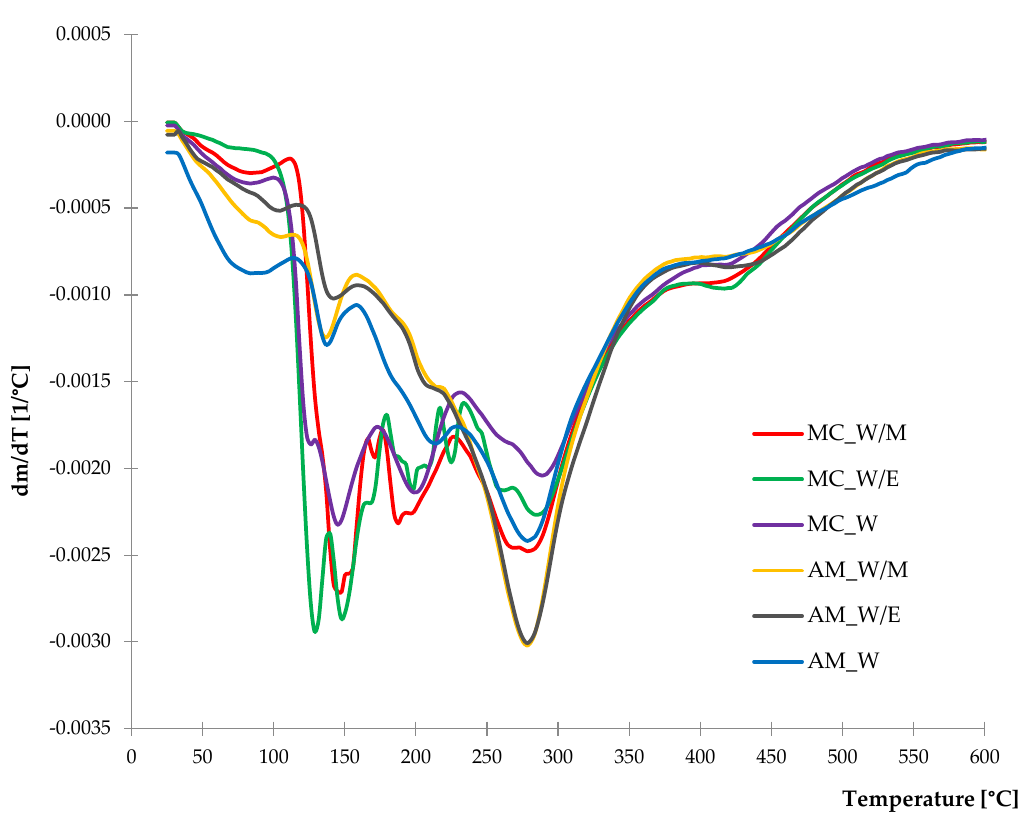
Figure 6. DTG curves of freeze-dried extracts. Table 3. Percentage mass losses (Δm ) of samples in various temperature ranges from 25 to 600 °C and residue after thermal decomposition at 600 °C (R 600 ).